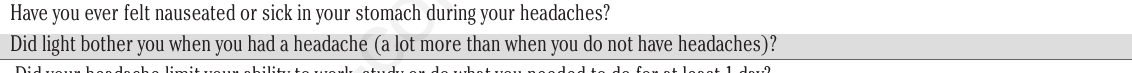
Table 1. The ID-Migraine Test. During the last 3 months, have you ever had the following with your headaches